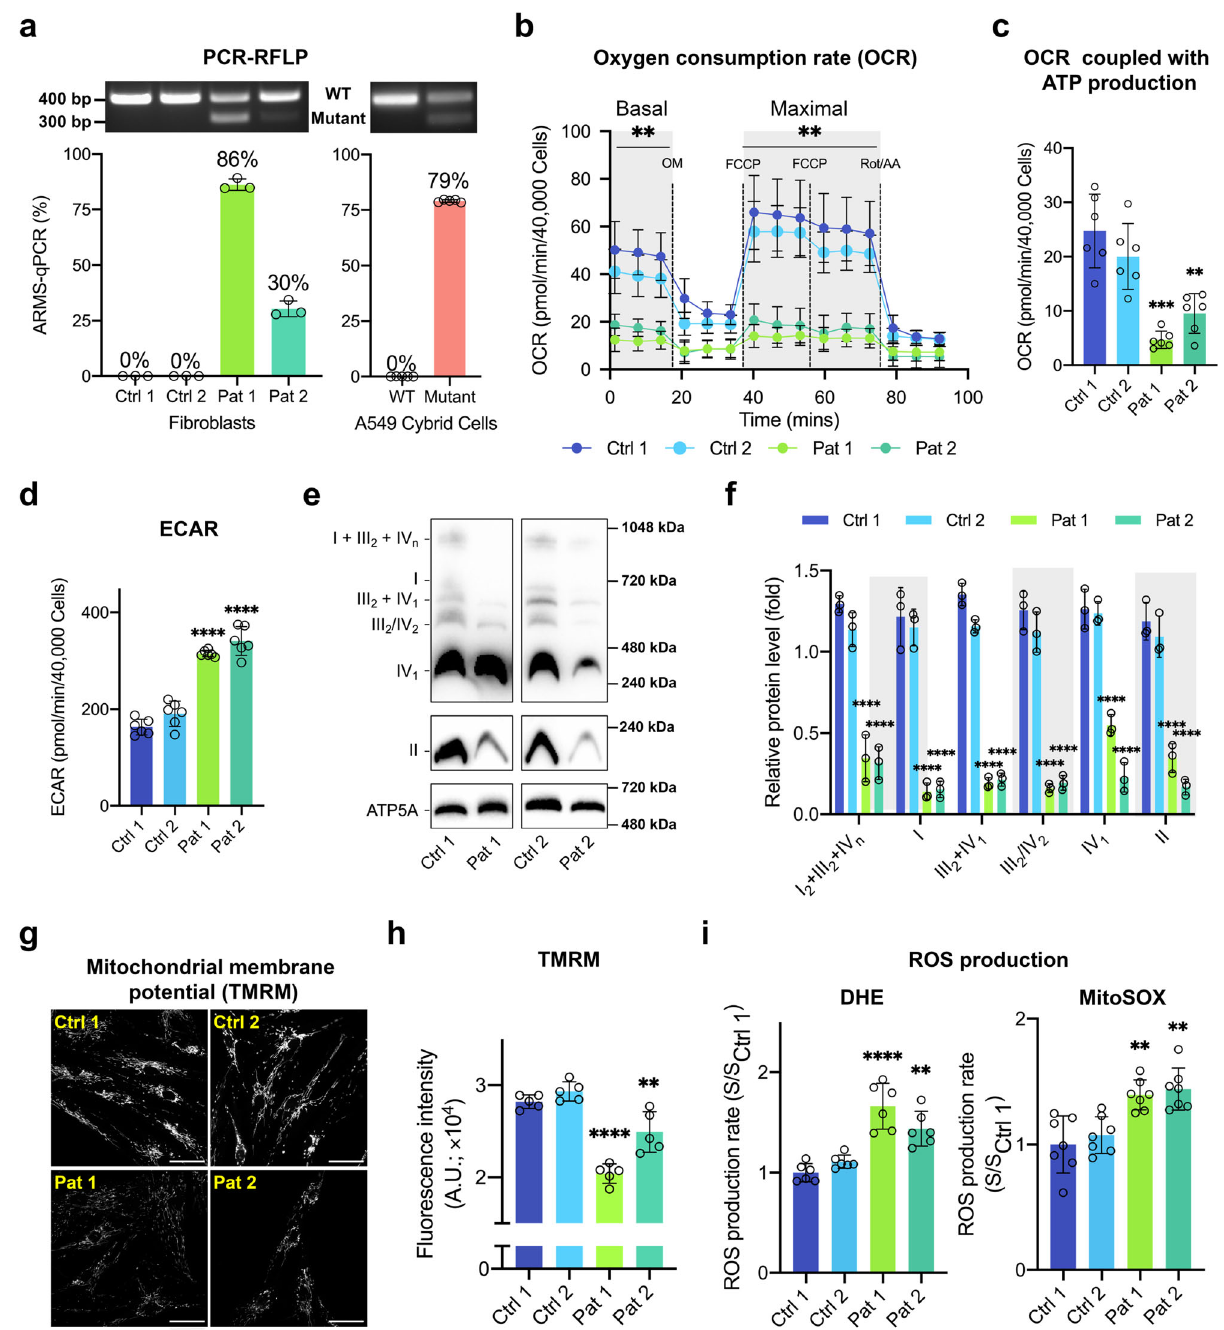
Fig. 1 The m.3243 A > G mtDNA mutation causes mitochondrial dysfunction and oxidative stress. a PCR-RFLP and ARMS-qPCR were used to quantify the mutation load for patient-derived fi broblasts ( n = 3 independent biological samples) and A549 cybrid cells ( n = 5 independent biological samples). b – d Cell respiratory capacity was measured using the Seahorse XFe96 extracellular fl ux analyser in patient fi broblasts ( n = 6 culture wells) showing a major decrease in oxygen consumption under all conditions ( b , p < 0.0001). Oxygen consumption dependent on ATP production ( c , p < 0.0001) — the response to oligomycin — and extracellular acidi fi cation rate (ECAR) are plotted ( d , p < 0.0001). e , f The expression of respiratory chain proteins and supercomplex assembly in patient fi broblasts were assessed using blue native gel electrophoresis (BNGE, e ) and quanti fi ed ( f , p < 0.0001), showing a major decrease in the assembly of all supercomplexes from the patient-derived cells ( n = 3 independent experiments). g , h The mitochondrial membrane potential of fi broblasts was measured using TMRM with confocal microscopy ( g ) and quanti fi ed ( h , p < 0.0001), showing a signi fi cant decrease in potential in patient-derived cells ( n = 5 independent experiments). Scale bar = 50 μ m. i ROS production rates of control and patient fi broblasts were measured using the reporters, DHE ( p < 0.0001) and MitoSOX ( p < 0.0001). Rates of ROS production were signi fi cantly increased in patient-derived cells ( n = 6 independent biological samples). Source data are provided as a Source Data fi le. All data were represented as mean ± SD and data were analysed by one- way ANOVA with Tukey ’ s multiple comparisons test (* p < 0.05, ** p < 0.01, *** p < 0.001, **** p < 0.0001).